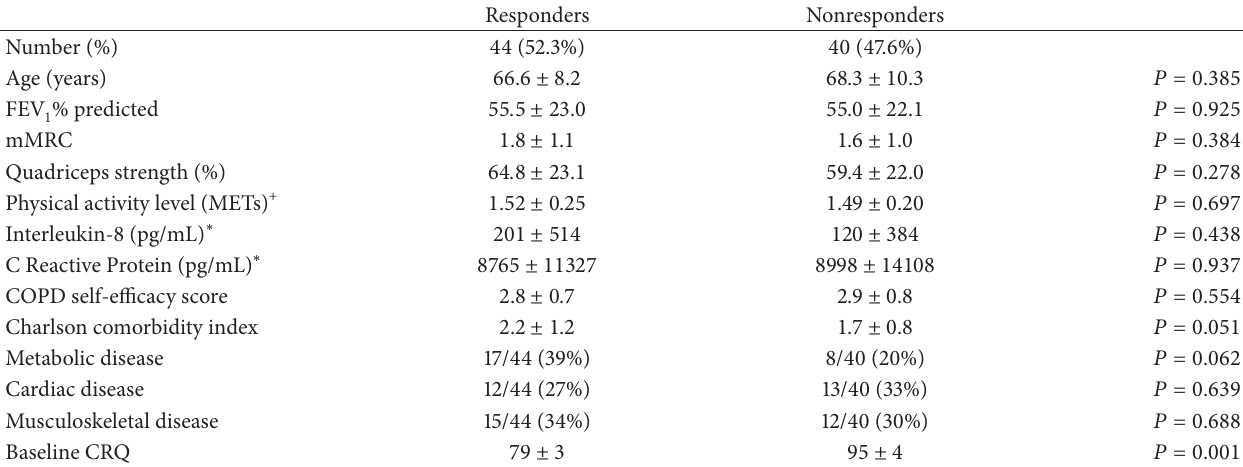
Table 2: Baseline assessment data for responders compared to non-responders in the Chronic Respiratory